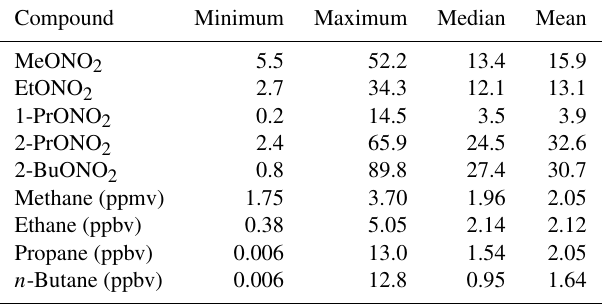
Table 2. Descriptive statistics of alkyl nitrate (pptv) and parent hy- drocarbons (ppbv) in whole-air samples collected at Tai O between 24 August 2001 and 31 December 2002 (from Simpson et al.,